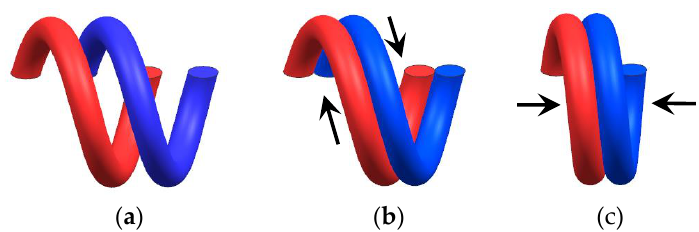
Figure 10. Three types of interaction during compression according to the EMWM micromechanics model: ( a ) non-contact, ( b ) slip contact, and ( c ) stick contact.